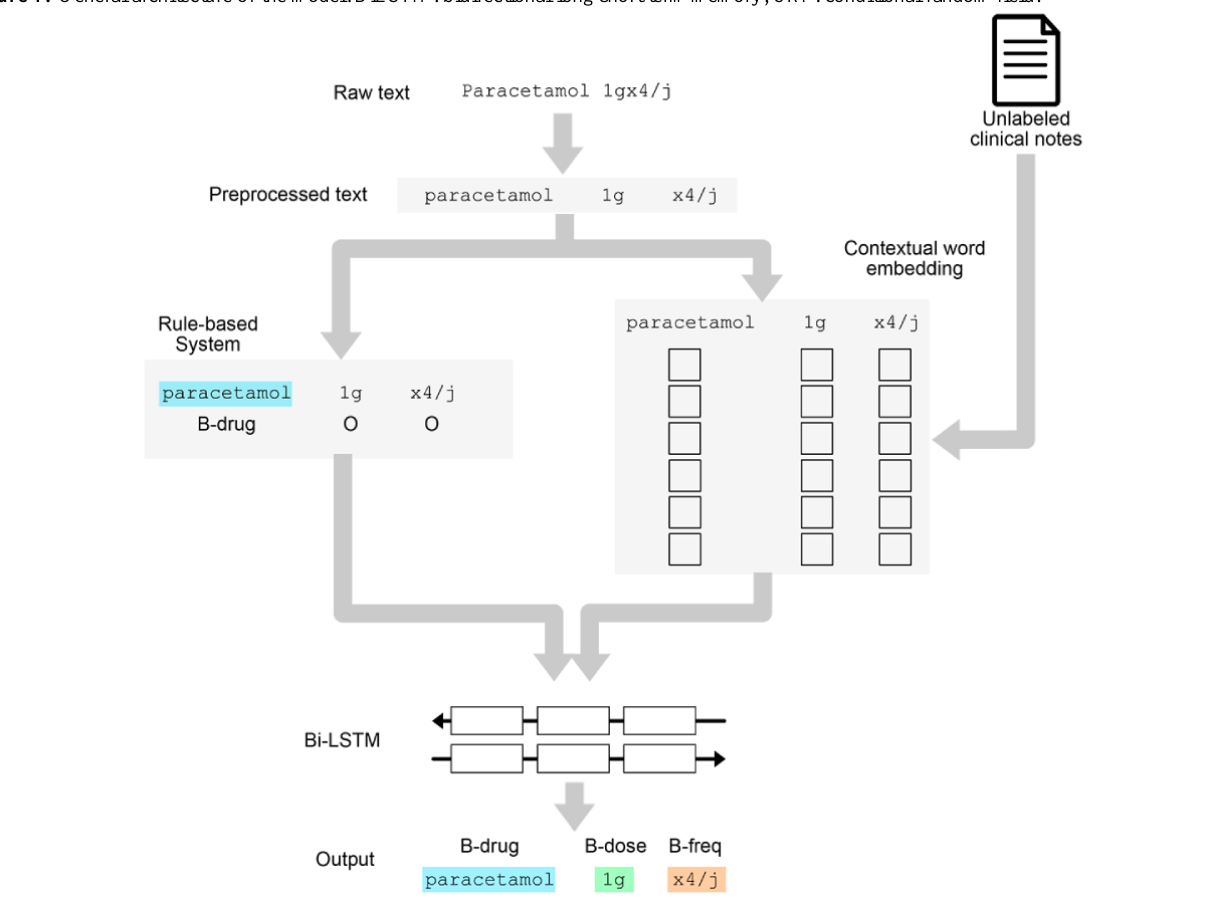
Figure 1. General architecture of the model. BiLSTM: bidirectional long short term memory; CRF: conditional random